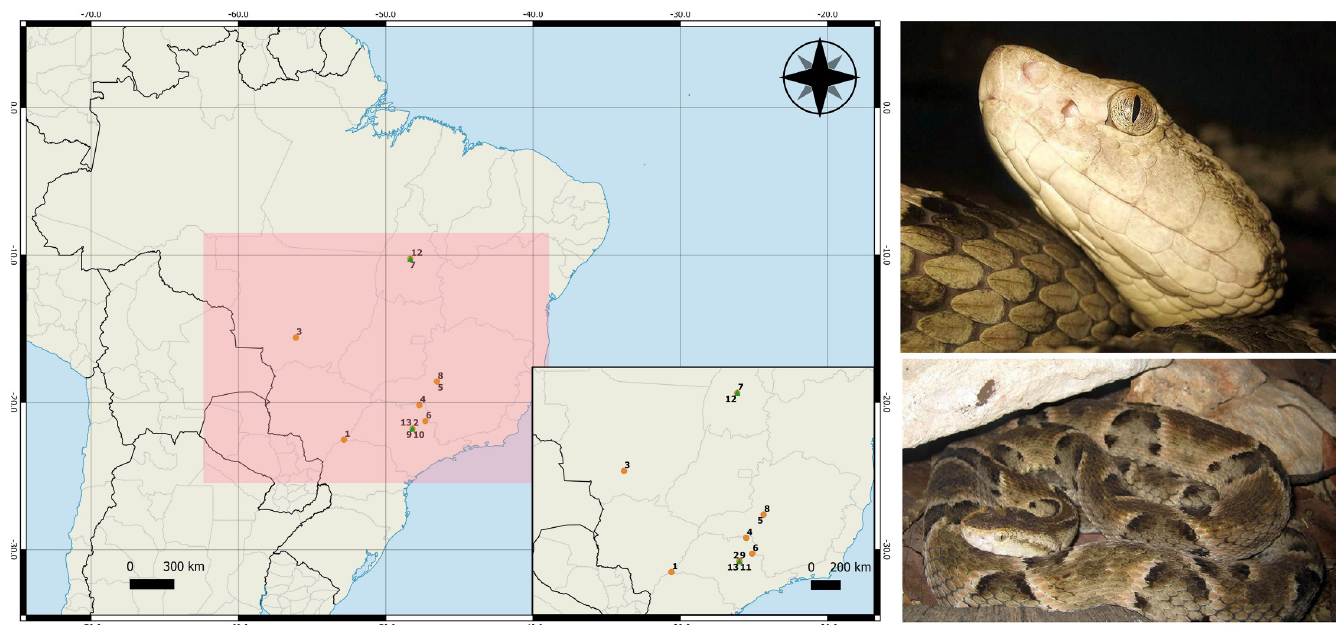
Fig 1. Geographic distribution of B . jararaca snakes used throughout this study. Orange dots represent female individuals and green triangles represent male ones.